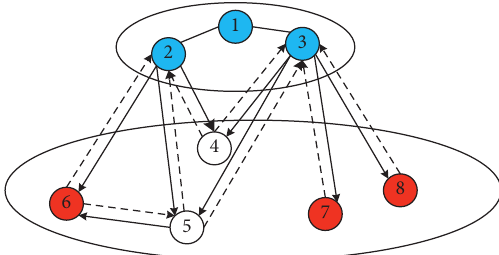
Figure 5: Reconfigurable network topology under